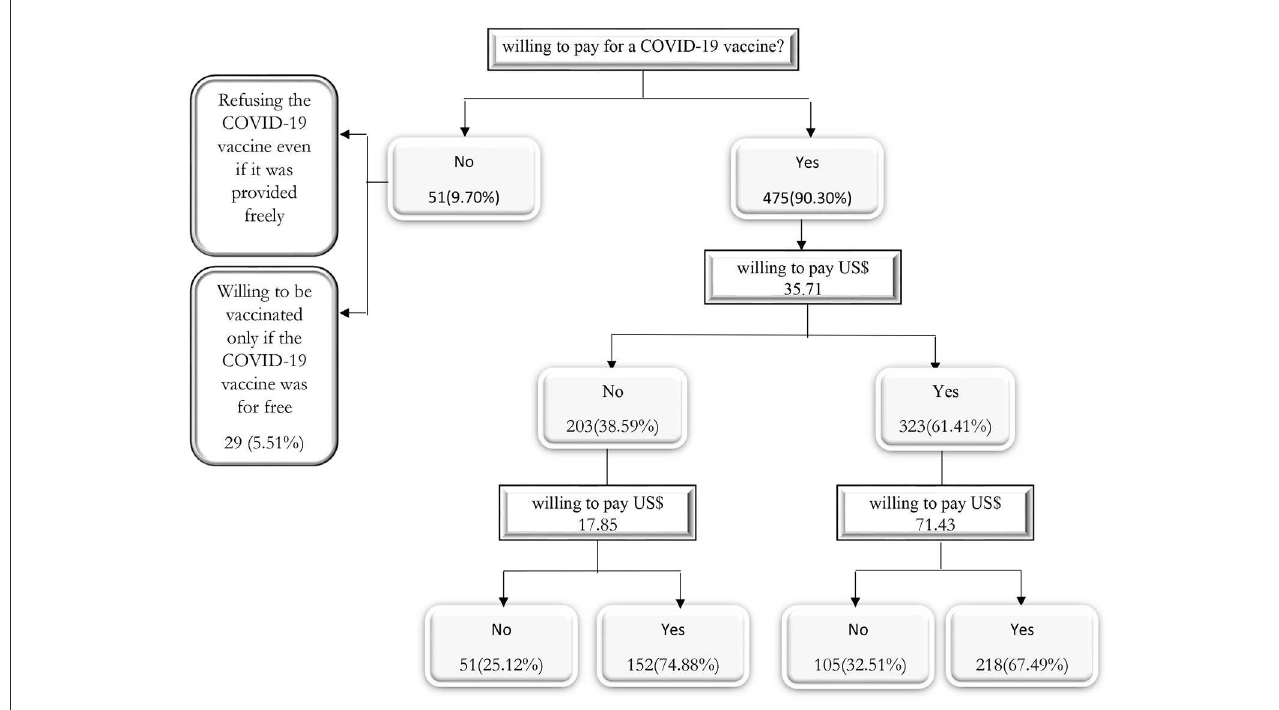
FIGURE1 Summary of statistics of the responses to the double-bonded dichotomous choice